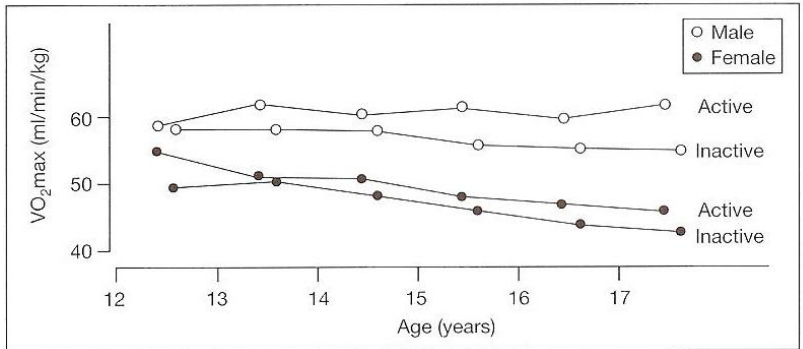
Figure 6. Development of VO 2 max per kg body weight in boys and girls with relatively high (active) and low (inactive patterns during the adolescent period of 12–17 years of age) [10].